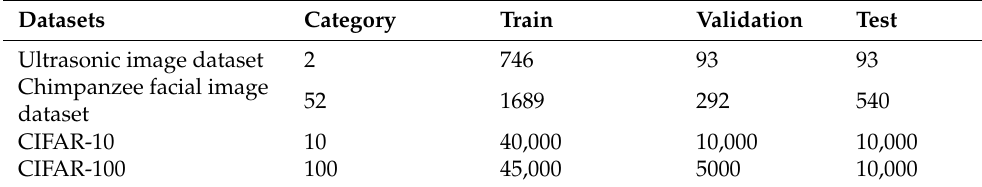
Table 1. Datasets